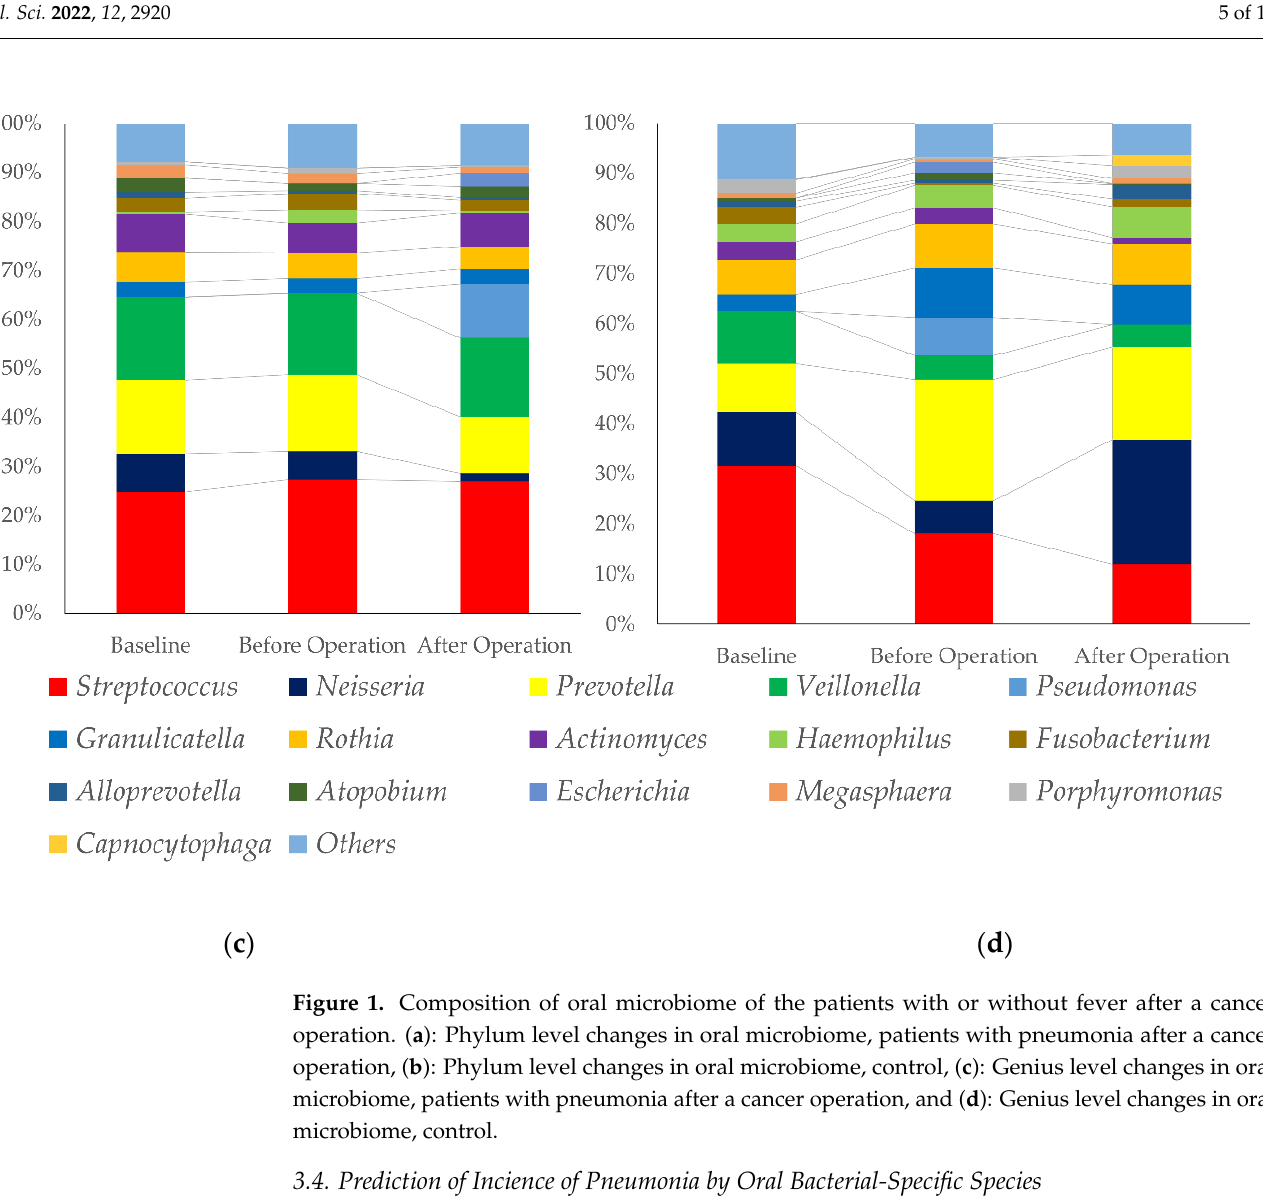
Table 1. Sensitivity and specificity of species levels of oral bacteria for the incidence of fever after operation; ( a ) Baseline; ( b ) Before cancer operation.